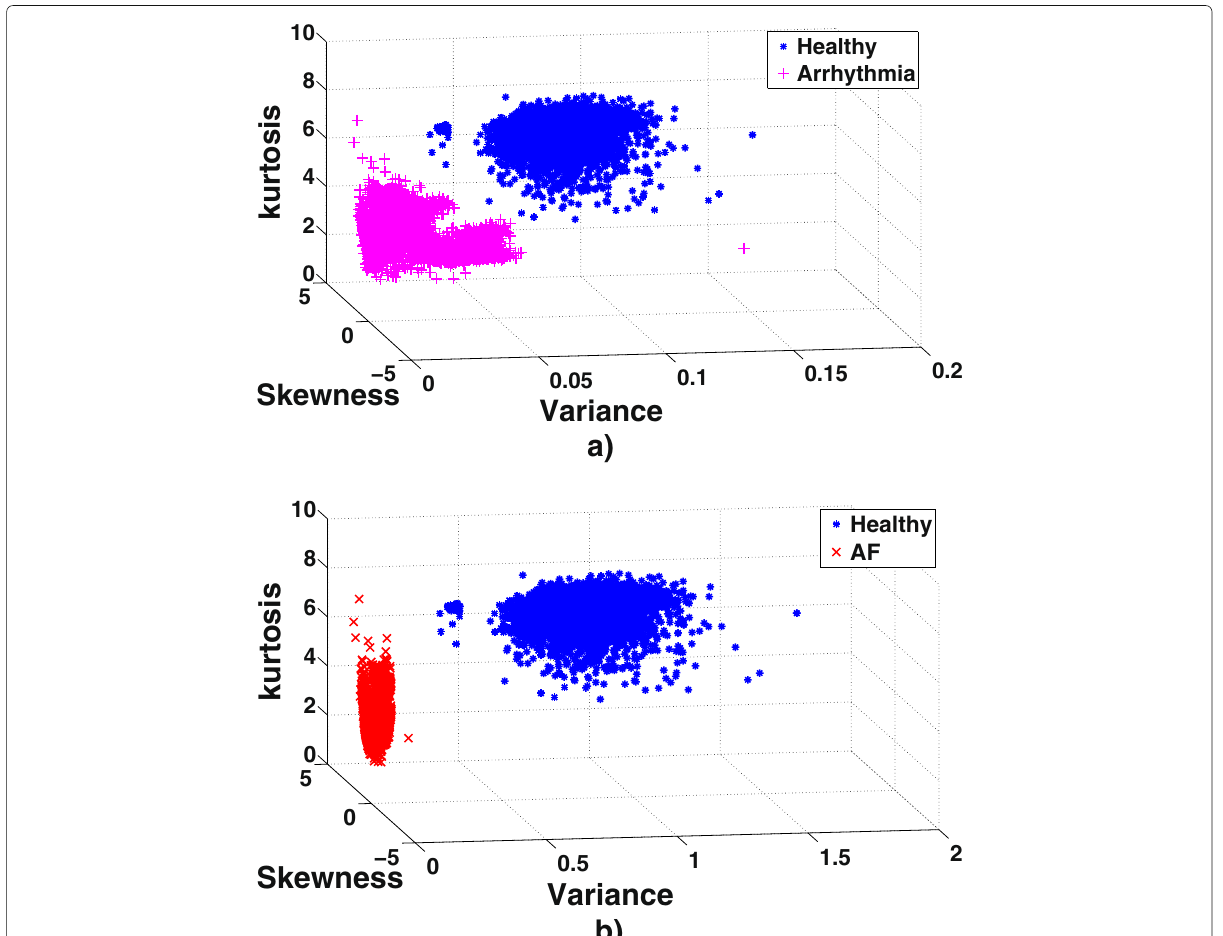
Fig. 3 Dispersion of the features extracted by the proposed method (variance, skewness, and kurtosis) for each heartbeat. a Features of healthy patients and patients with arrhythmia. b Features of healthy patients and patients with